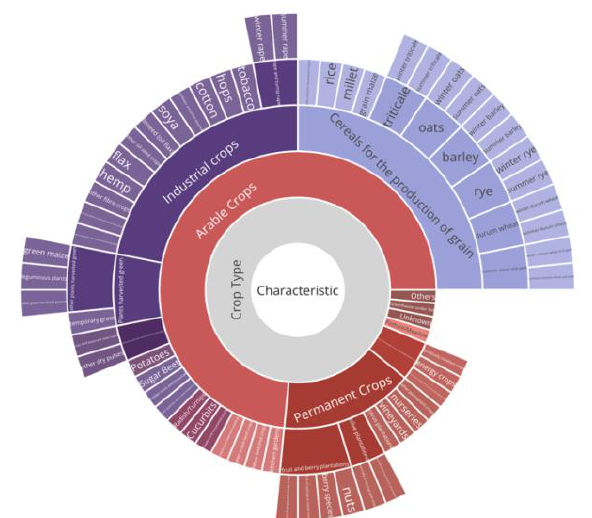
Figure 2. A representation of the EuroCrops taxonomy classes and levels (Schneider et al. 2021).